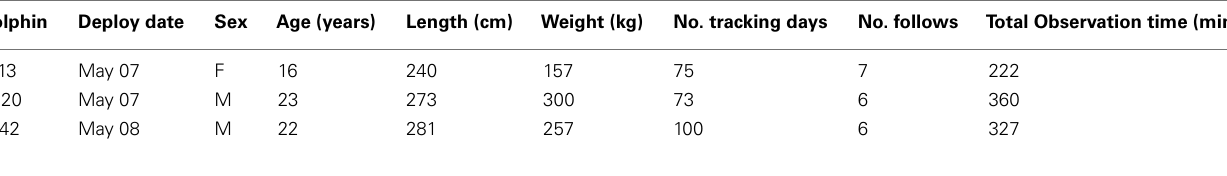
Table 1 | Sarasota Bay dolphins tagged with satellite-linked transmitters in May